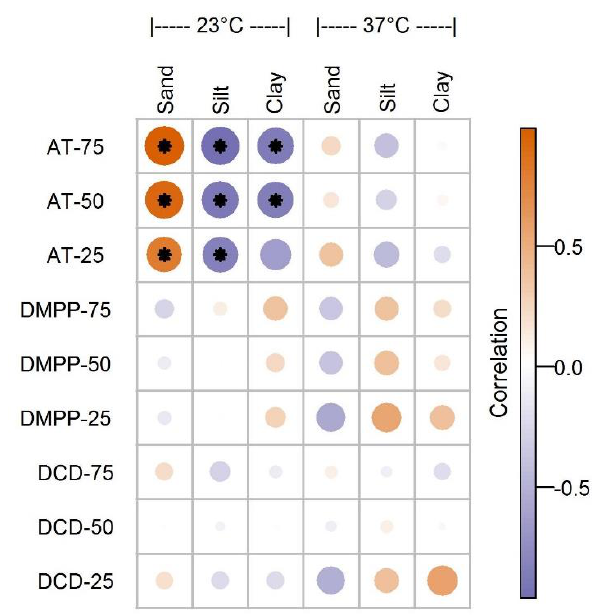
Figure 4. Pearson correlation between the inhibitory effects of dicyandiamide (DCD), 3,4-Dimethylpyrazole Phosphate (DMPP), and allylthiourea (AT) and the soil texture at 23 and 37 °C. Circle diameter and color represent the magnitude of the correlation. * Indicates statistical significance ( p < 0.05).